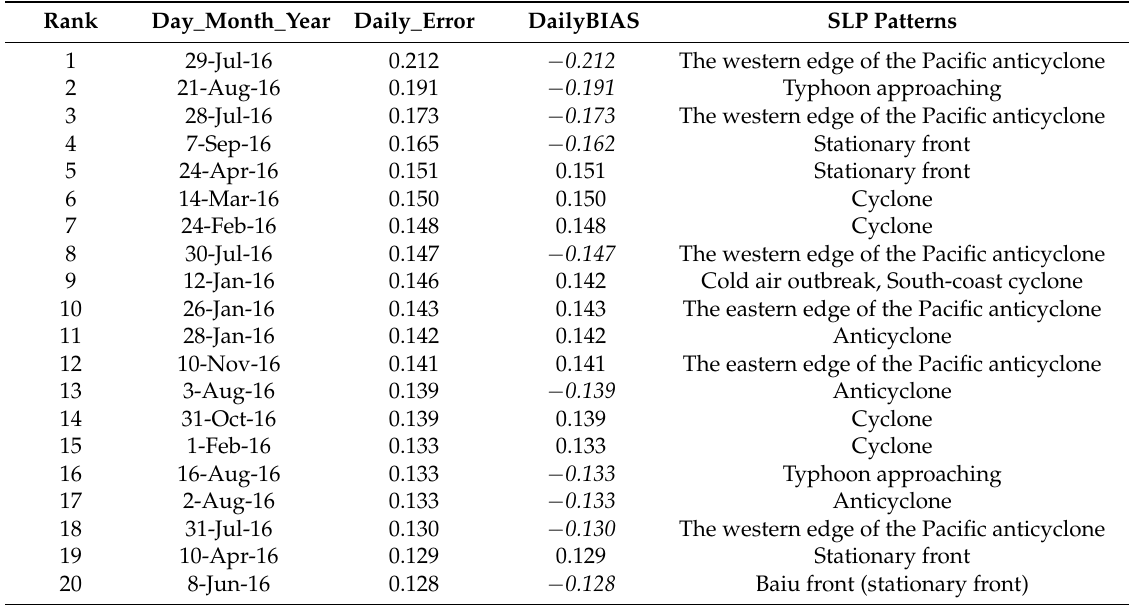
Table 4. Same as Table 2, but for 2016.